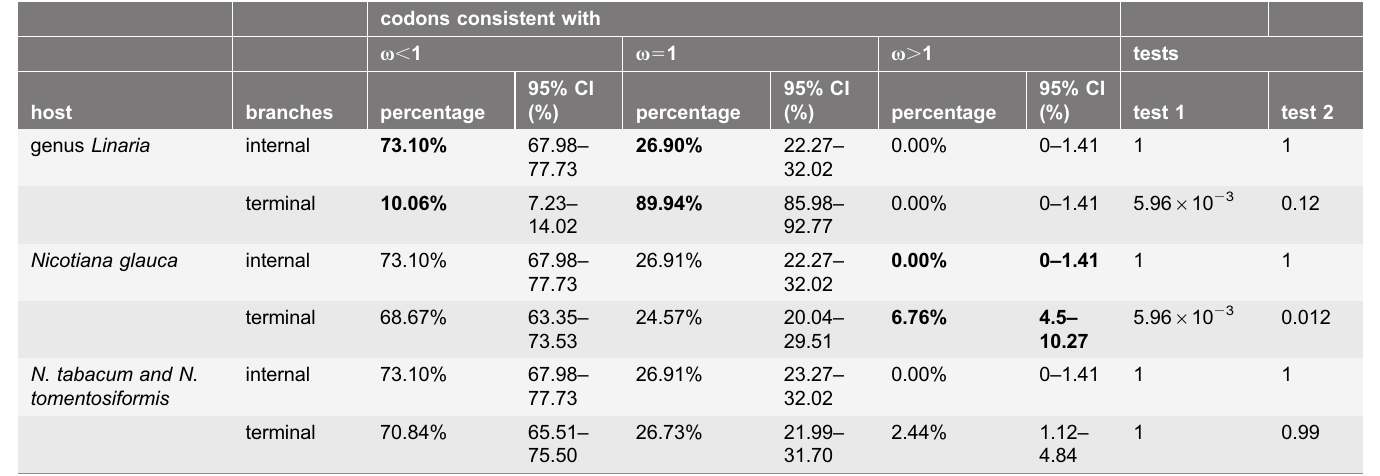
Table 2. Branch-site analysis of mikimopine synthase evolution before and after